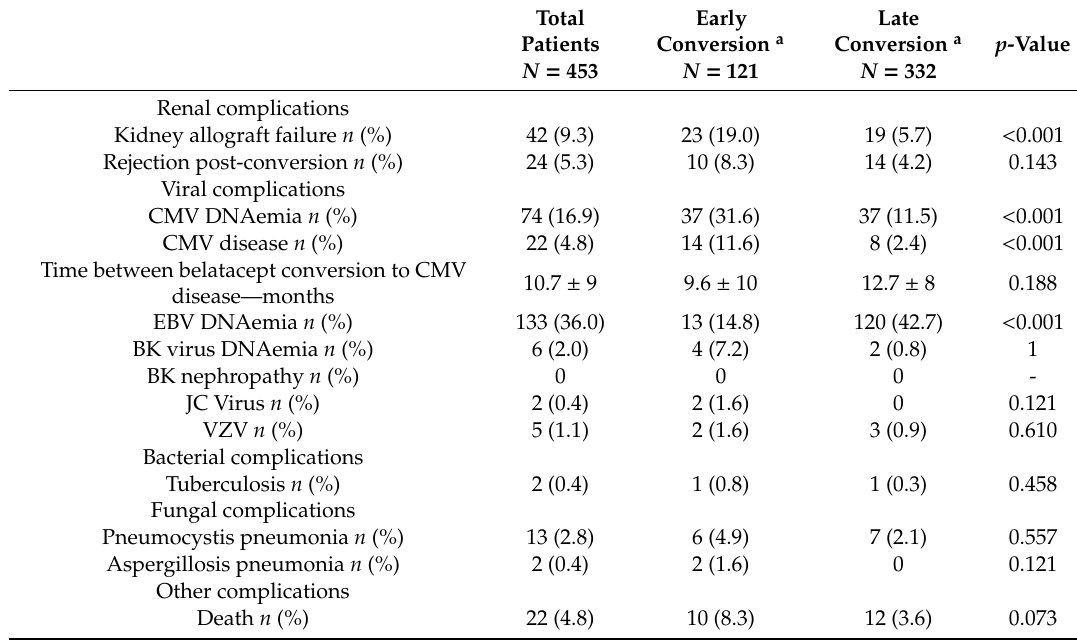
Table 2. Complications after conversion to